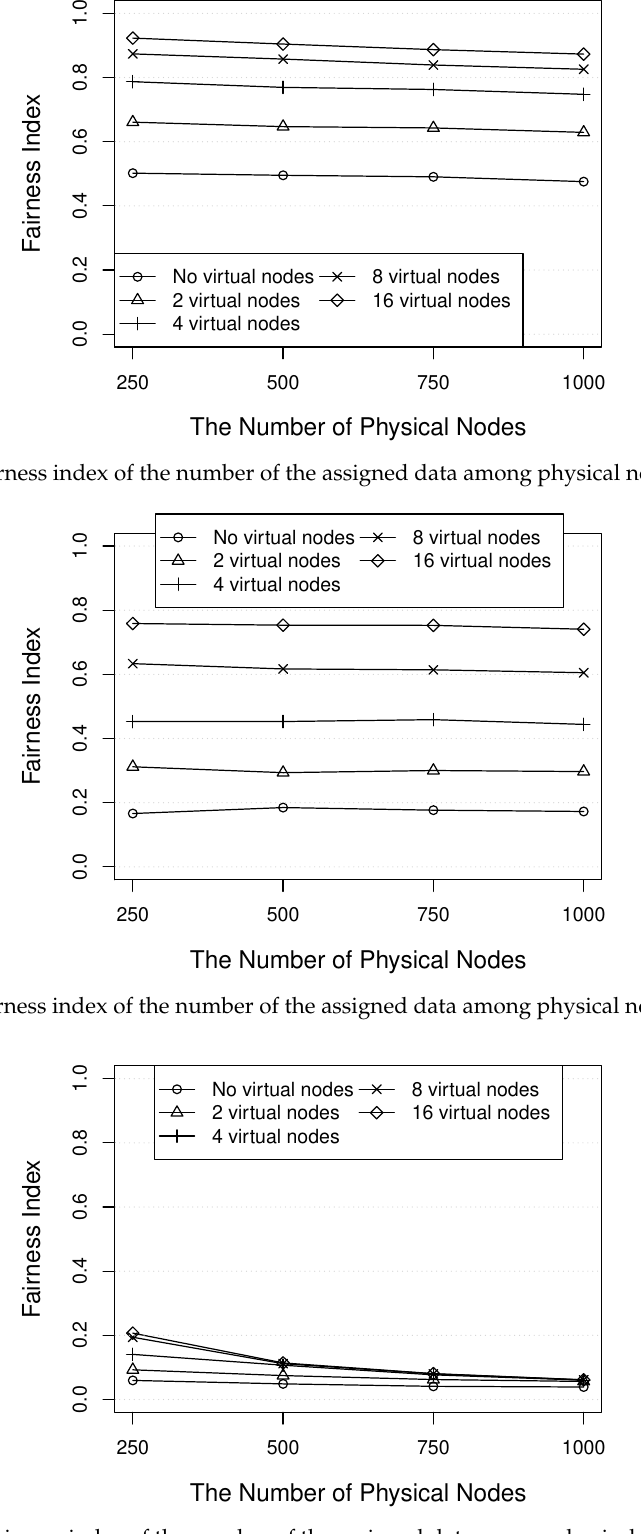
Figure 11. The fairness index of the number of the assigned data among physical nodes